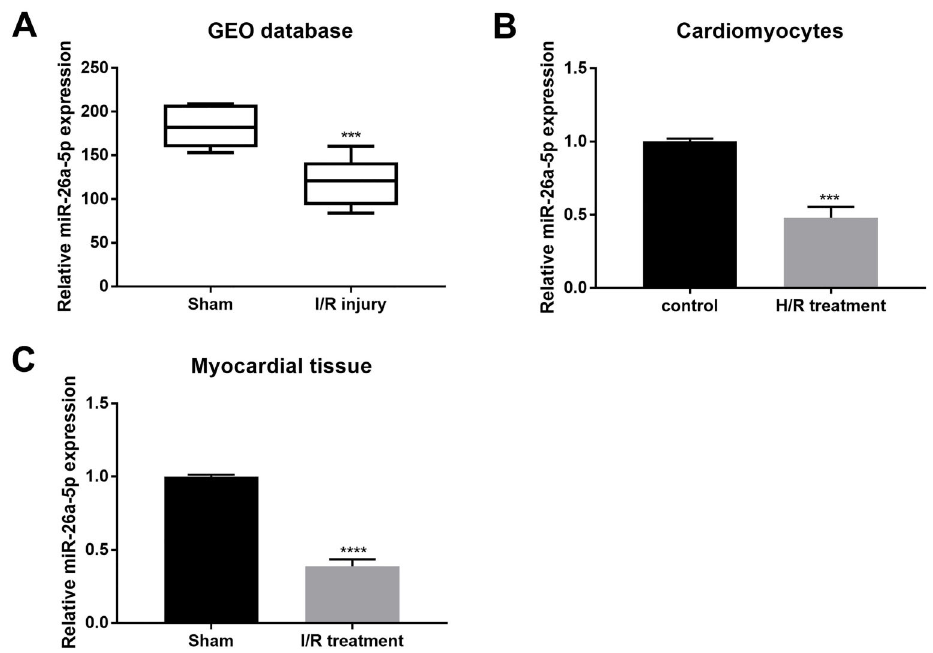
Figure 2. Detection of miR-26a-5p expression. A , The expression data of miR-26a-5p from GEO database were analyzed (medians and interquartile ranges). qRT-PCR was applied to analyze the expression of miR-26a-5p in ( B ) cardiomyocytes submitted to hypoxia/ reoxygenation (H/R) treatment and ( C ) myocardial tissue upon ischemia/reperfusion (I/R) injury. Data are reported as means ± SD. ***P o 0.001, ****P o 0.0001 vs control groups ( t